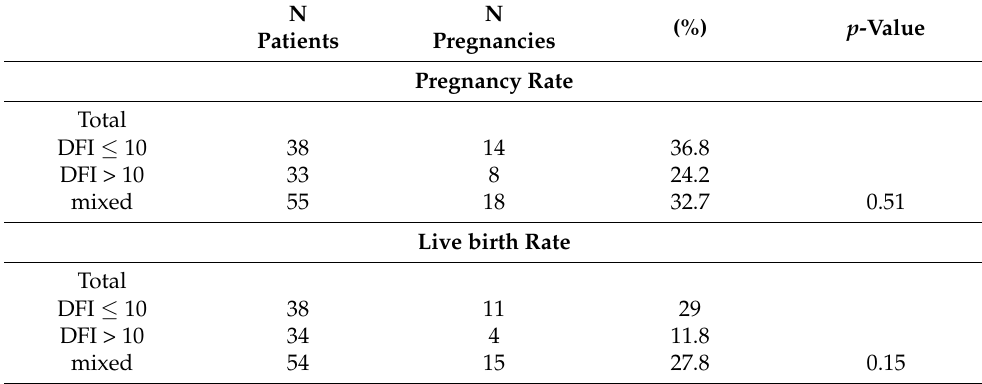
Table 6. DFI can in some males fluctuate. The males are divided into three groups. DFI ≤ 10: a minimum of two samples with a DFI ≤ 10, DFI > 10: a minimum of two samples with a high DFI > 10, or mixed: minimum one sample with low DFI ≤ 10 and 1 sample with high DFI >